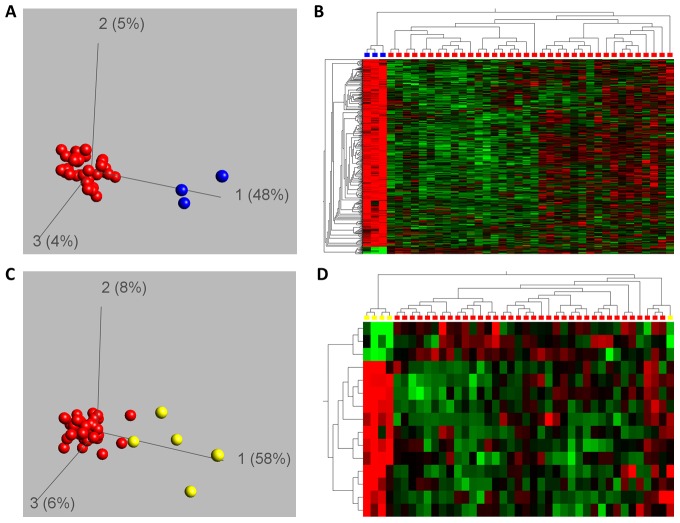
DNA methylation patterns in CVS samples with chromosomal imbalances.PCA (A) and Hierarchic cluster analysis (B) of DNA methylation values of 464 CpG loci differentially methylated between chorionic villi biopsy samples without chromosomal imbalances (red spheres or red squares, respectively) and samples with trisomy 21 (47,XY+21; blue spheres or blue squares, respectively) (FDR<0.01). While in cases with trisomy 21 numerous epigenetic alterations could be identified, in cases with trisomy 18 (47,XX+21/47,XY+21, yellow spheres or yellow squares) only 15 differentially methylated loci have been found (C and D). Green color in the heatmap indicates low DNA-methylation, black intermediate and red high DNA-methylation values.